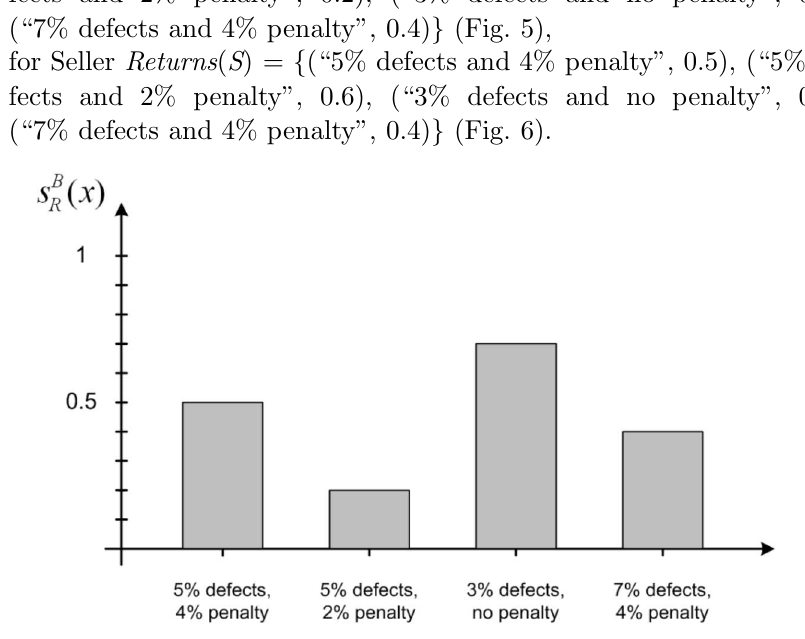
Figure 5. The Buyer’s membership function for returns